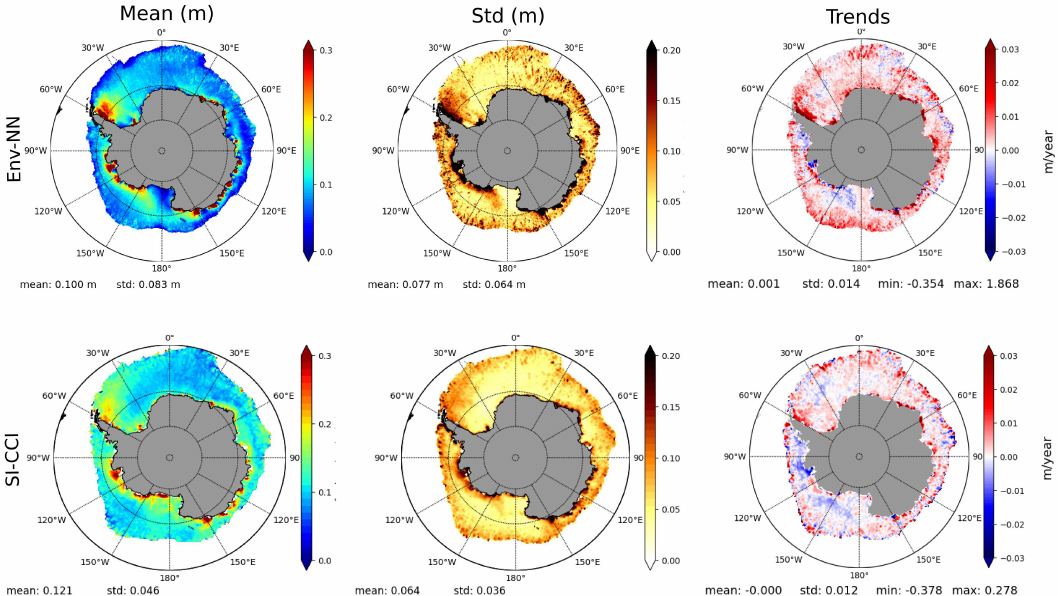
Figure 4. Comparisons between radar freeboard Envisat estimations computed from the neural network calibration (Env-NN, first line) and the SI-CCI Envisat solution (second line). The first column presents the 2003–2011 climatological mean maps and the second column the associated standard deviations. For the 2 datasets, maps of the 2003–2011 radar freeboard trends are provided in the third